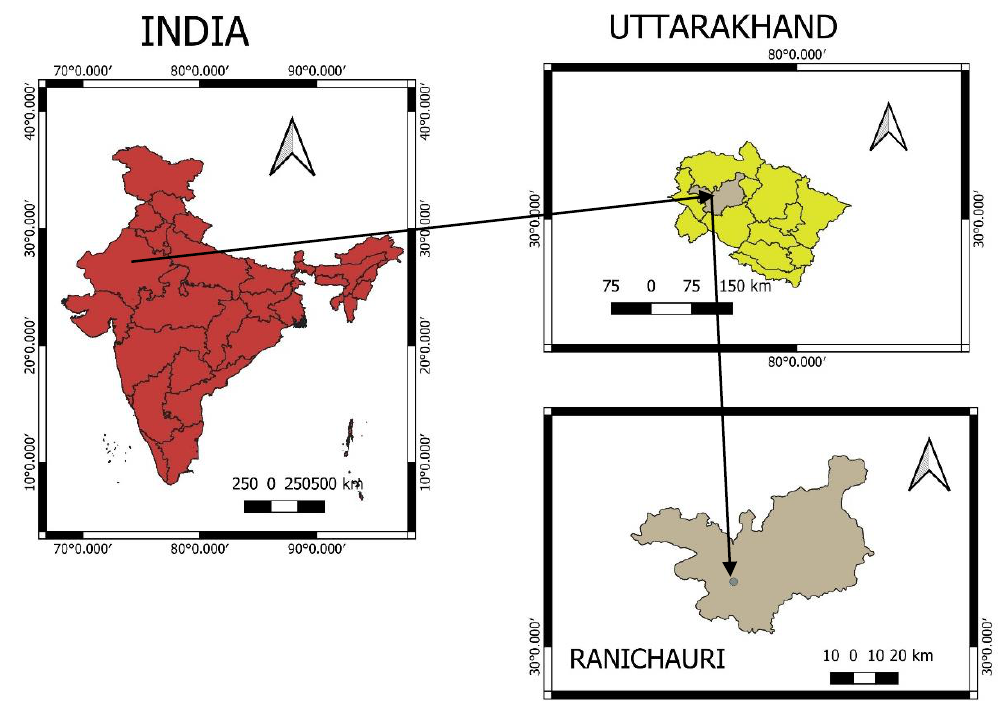
Figure 1. Location map of watershed: Ranichauri, Uttarakhand's Northern Indian